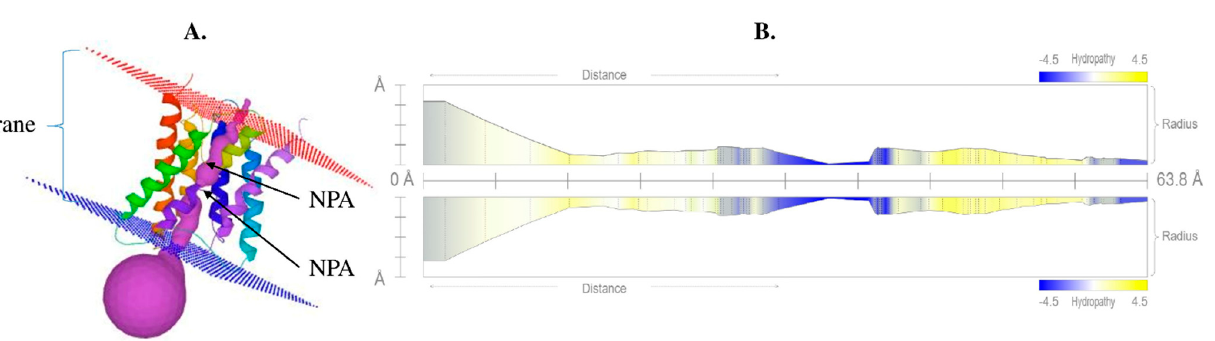
40 AQPs genes, which are represented with the help of different colors. ( B ) Gene structure analysis and organization of the intron–exon of VaAQPs . Exon–intron structure analyses were performed using the TBtool; yellow boxes represent the CDS, green boxes represent the UTR, and black lines represent introns. The scale below Figure 3 represents the position of the CDS, UTR, and motif from base pair (bp).